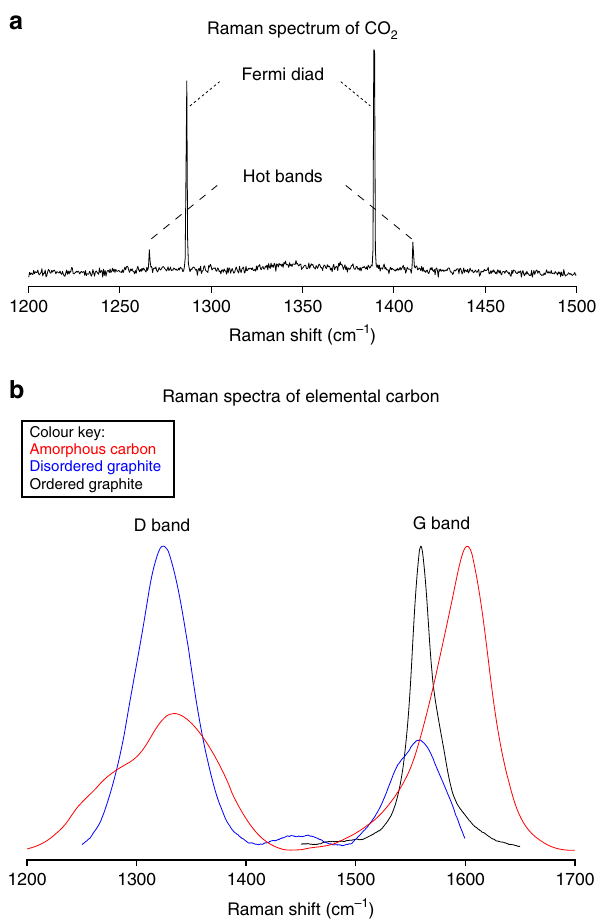
Fig. 5 Raman spectra of CO 2 and elemental carbon. a Raman spectrum of CO 2 , acquired on sample NS9 (Nova Scotia, Canada). The Fermi diad is represented by sharp bands, at 1285 cm − 1 and at 1388 cm − 1 , and the hot bands are represented by symmetrical weak bands, below 1285 cm − 1 and above 1388 cm − 1 . b Raman spectra of elemental carbon: amorphous carbon acquired on sample NEW31 (New Jersey, USA), disordered graphite acquired on sample AN39 (Morocco), and ordered graphite (detail on the G band) acquired on a common pencil. Compared to the ordered graphite Raman spectrum, our Raman spectra of disordered graphite and amorphous carbon always have one or more D peaks between 1200 and 1400 cm − 1 . The G band lower than 1590 cm − 1 indicates disordered graphite, while the G band higher than 1590 cm − 1 indicates amorphous carbon (see “ Methods ” section). The D band is often composed by two peaks (D1 at ca. 1350 cm − 1 and D5 at ca. 1270 cm − 1 ) for both disordered graphite and amorphous carbon.